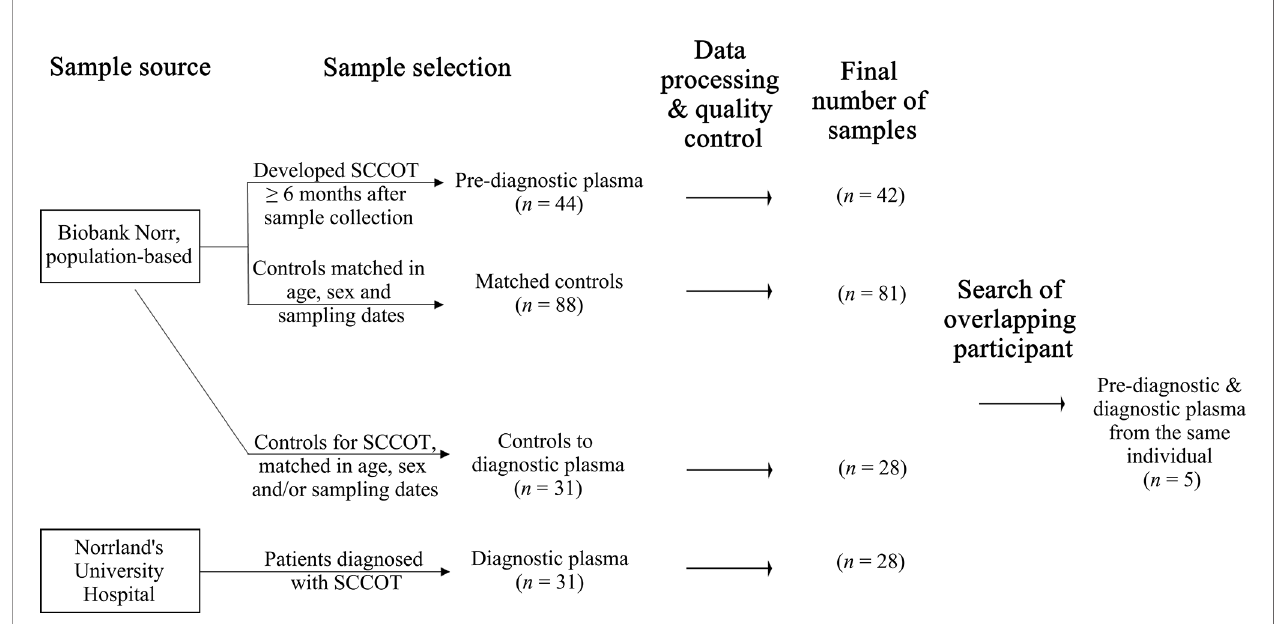
FIGURE 1 | Sample selection and the fi nal sample set with quali fi ed